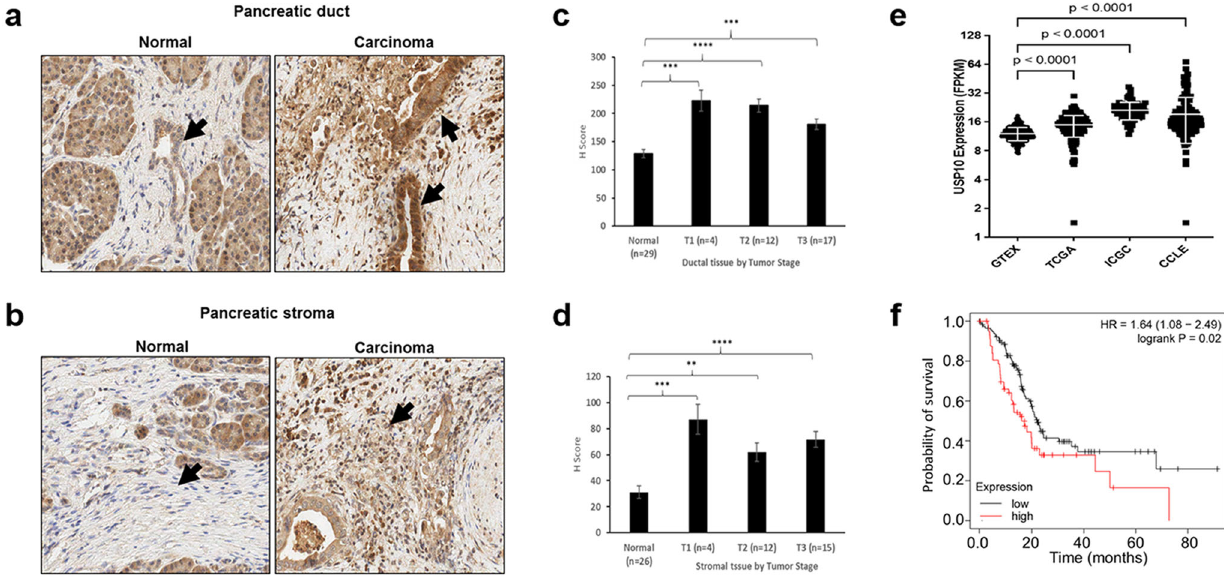
Fig. 1 Expression and signi fi cance of USP10 in pancreatic cancer. ( a – d ) Expression of USP10 in pancreatic tissues: Normal and Pancreatic cancer patients (Ductal tissues: Normal, n = 29; cancerous T1 n = 4; T2 n = 12, T3 n = 17 & Stromal tissues: normal ( n = 26) and cancerous, T1 n = 4; T2 n = 12; T3 n = 15) stained by immunohistochemistry (IHC) to assess the expression levels of USP10 protein. Data were analyzed by Linear Mixed Model. The H-score for ductal tissue in normal sample is estimated to be 93.95, 85.49, and 52.77 units less than the H-score in T1, T2, and T3 sample respectively ( p -value 0.0001, <0.0001, and 0.0001). There is no signi fi cant difference between pairwise comparisons of T1, T2, and T3. Similarly, for stroma, the H-score in normal sample is estimated to be 55.90, 30.76, and 40.51 units less than the H-score in T1, T2, and T3 sample respectively ( p -value 0.0002, 0.0023, and <0.0001). There is no signi fi cant difference between pairwise comparisons of T1, T2, and T3. e Levels of USP10 mRNA in normal pancreas (GTEx), pancreatic cancer cell lines (CCLE) and pancreatic cancer tissues (ICGC and TCGA). Data represent mean ± SD. Using Kruskal-Wallis rank sum test, the FPKM/expression was signi fi cantly higher in TCGA, ICGC, and CCLE compared to GTEx ( p -value <2.2e − 16). f Kaplan-Meier overall survival curves in USP10 low and high expression pancreatic cancer cases ( p = 0.02). The proportion survival is plotted versus time (since diagnosis in month). Kaplan-Meier curves with a log-rank test where P value < 0.05 is considered signi fi